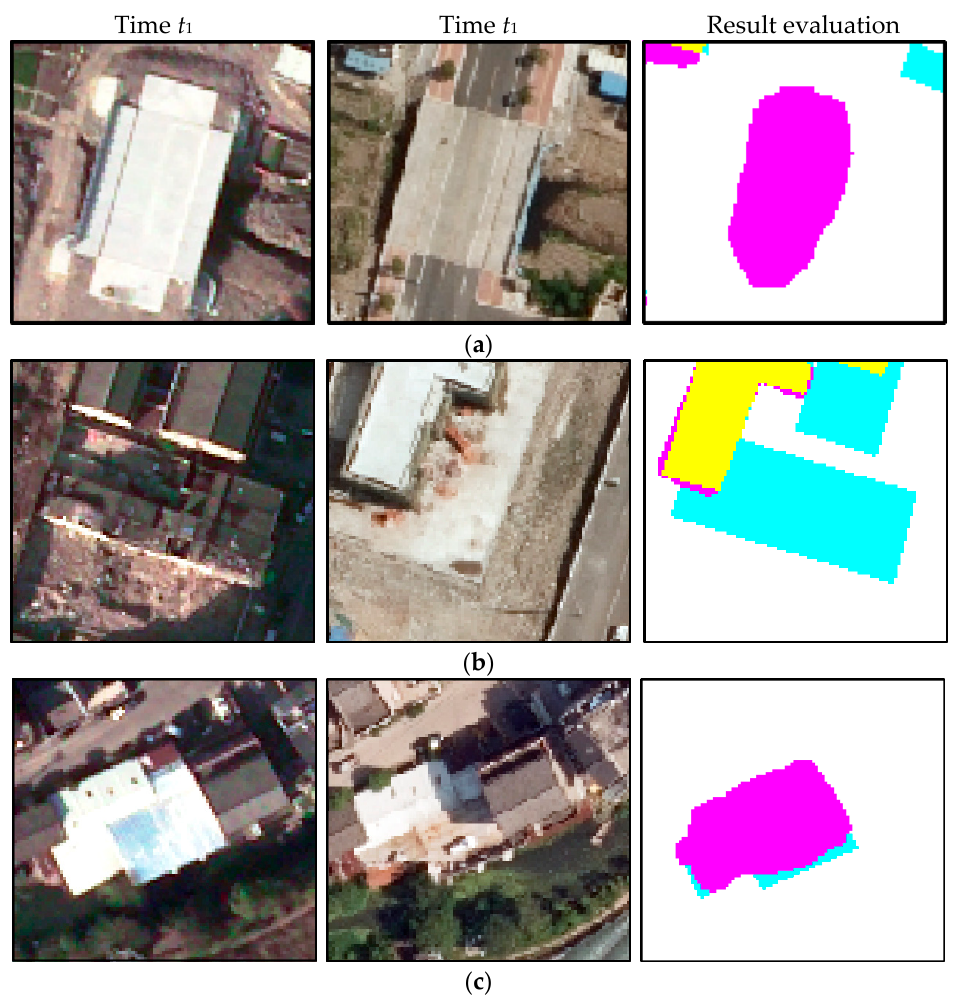
Figure 19. Limitations to the proposed method for Dataset 2: ( a ) wrong detection caused by the interference of suspected building objects, ( b ) missed detection caused by confused changed buildings, and ( c ) misclassified detection caused by broken roofs.